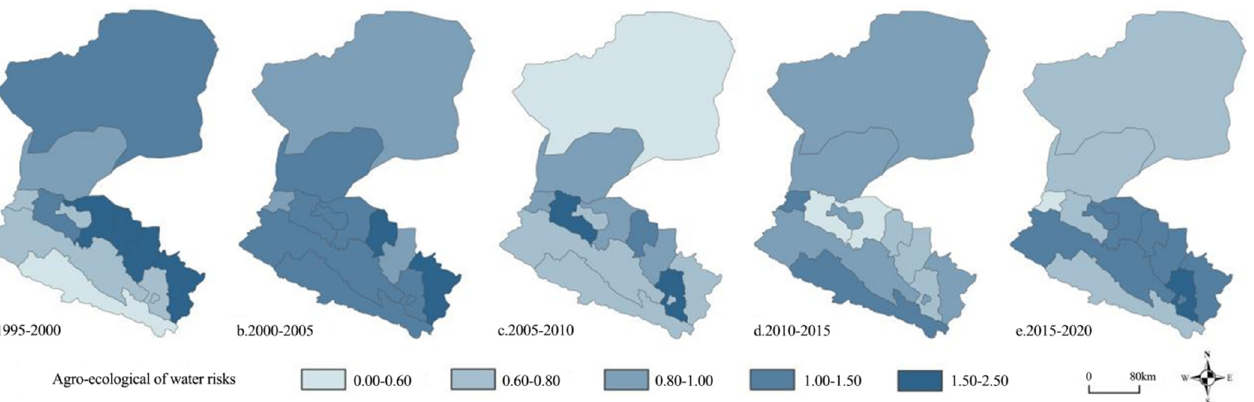
Table 5. Agroecological risk index and decomposition of land in the HRB by time period, 1995–